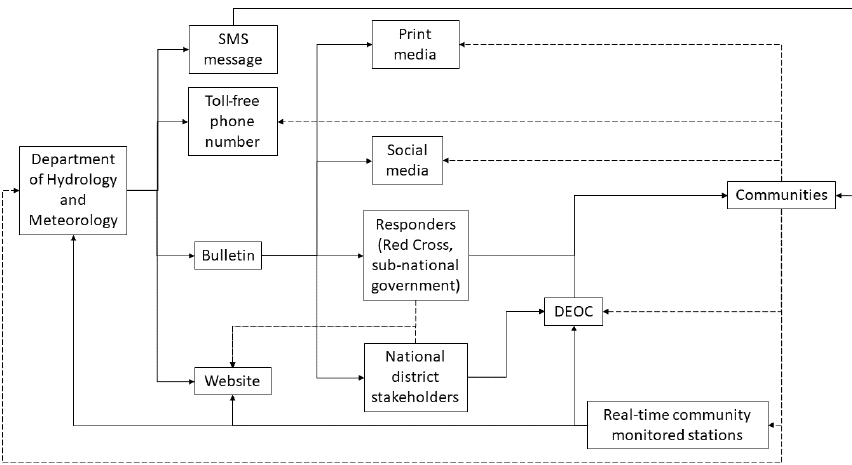
Figure 3. Flows of forecast and early warning information in Nepal as of 2017 monsoon. Solid lines indicate actively “pushed” information; dashed lines indicate accessible “pulled” information.